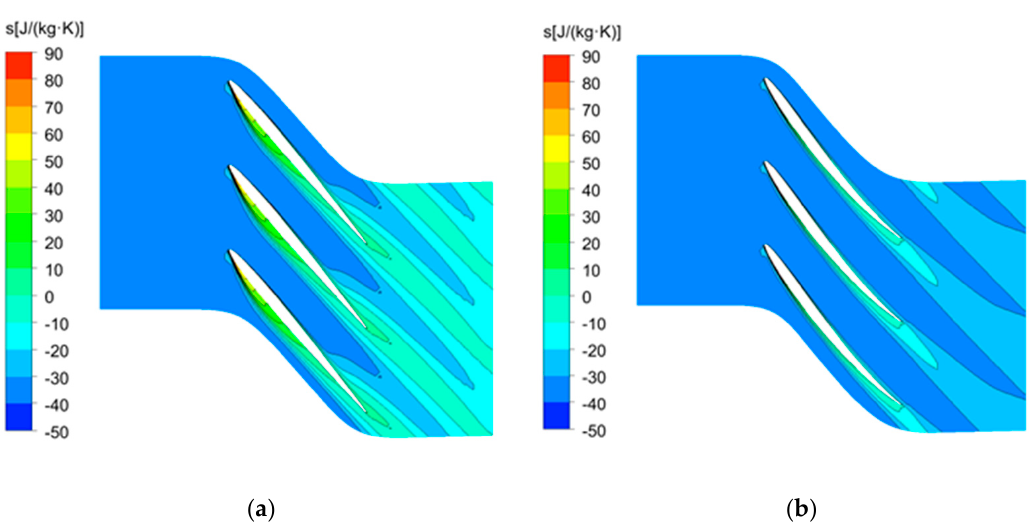
Figure 14. Entropy increased contours at 80% span of the original ( a ) and optimized ( b ) blades.